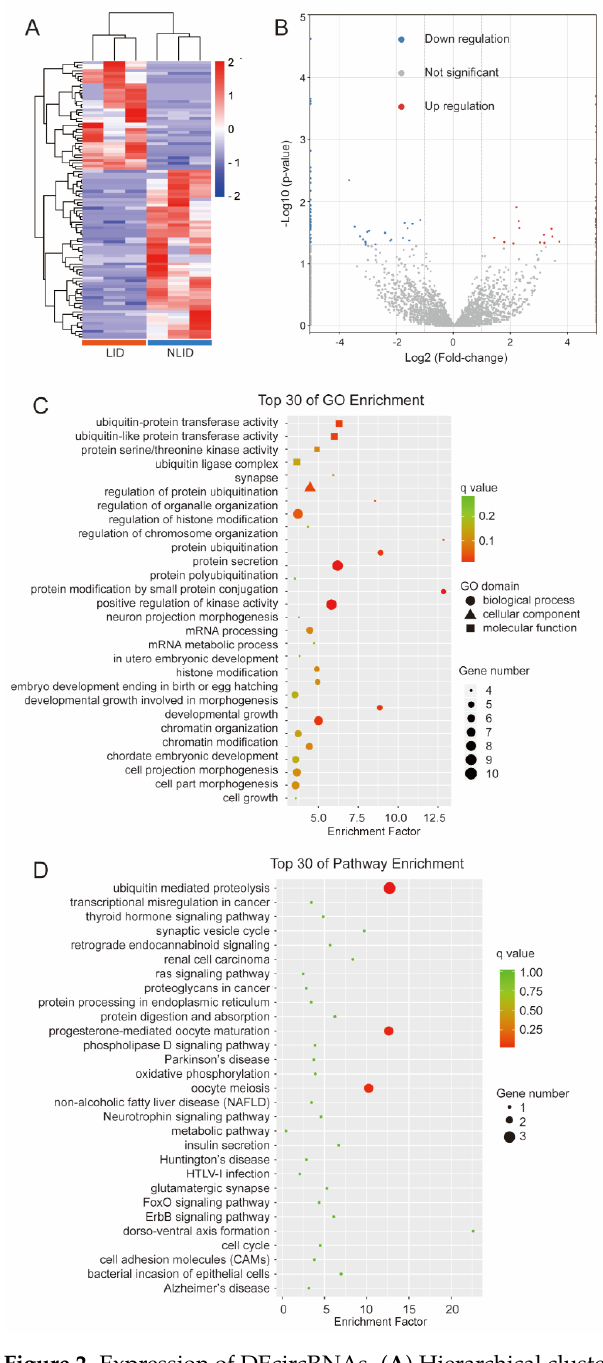
Figure 2. Expression of DEcircRNAs. ( A ) Hierarchical clustering of DEcircRNAs in LID (levodopa- induced dyskinesia) rats compared to non-LID (NLID) rats. The expression values are denoted using a color scale. The intensity increases from red (relatively higher expression) to blue (relatively lower expression). Different columns represent different samples ( n = 6), and each row represents a single circRNA. ( B ) Volcano plot of circRNAs. A total of 39 up-regulated and 60 down-regulated circRNAs were screened out. Up-regulated and down-regulated circRNAs are denoted in red and blue, respectively. ( C ) Gene Ontology (GO) enrichment analysis. The abscissa is the rich factor, and the ordinate represents the GO terms. The size of the dot represents the number of genes annotated to the GO term. The color of the dot represents the q value. ( D ) Kyoto Encyclopedia of Genes and Genomes (KEGG) enrichment analysis. The size of the dot represents the number of genes annotated to the KEGG term. The color of the dot represents the q value.